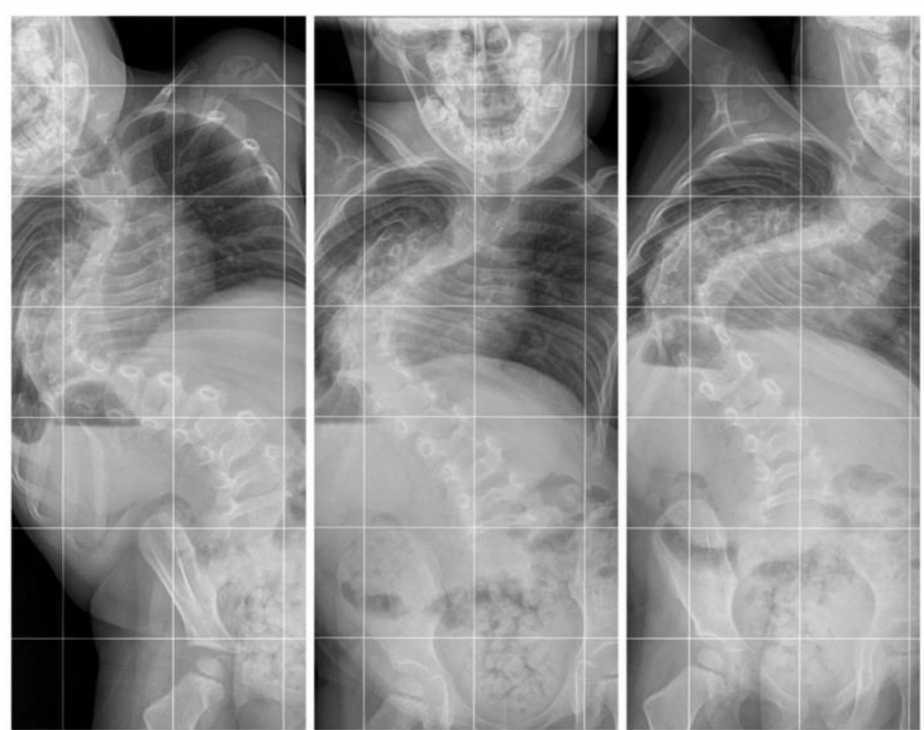
Figure 4. AP standing bending